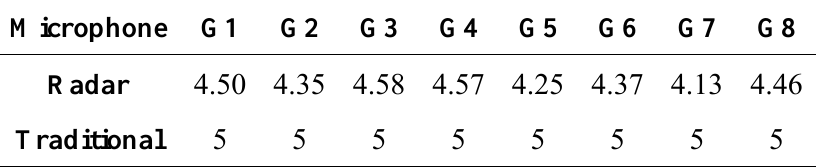
Table 1. MOS of the radar sensor speech and traditional microphone